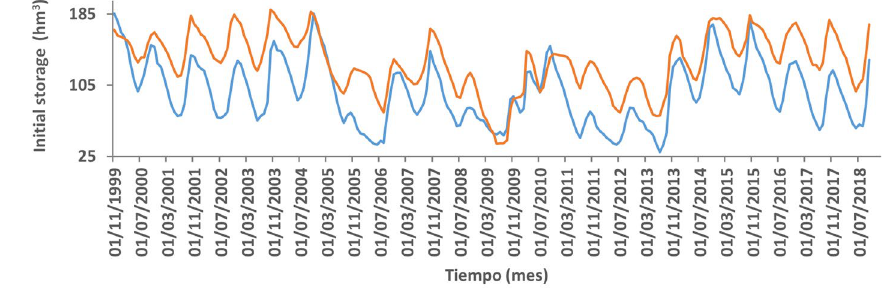
Fig. 11 The total monthly initial water storage level: the histori‑ cal record versus the simulated values established with genetic algorithm GA2